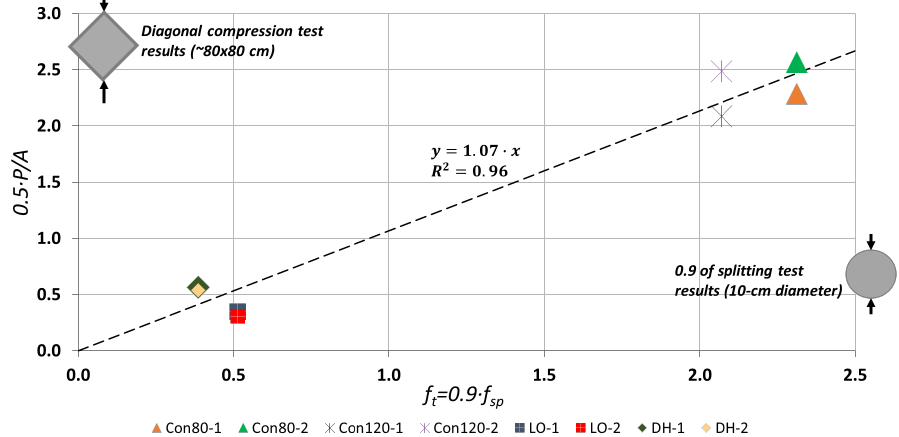
Figure 8. Relationship between tensile strength by diagonal compression test ( Y -axis) and tensile strength by splitting tensile test ( X -axis), Reprinted with permission from [14], Copyright 2021 Elsevier.